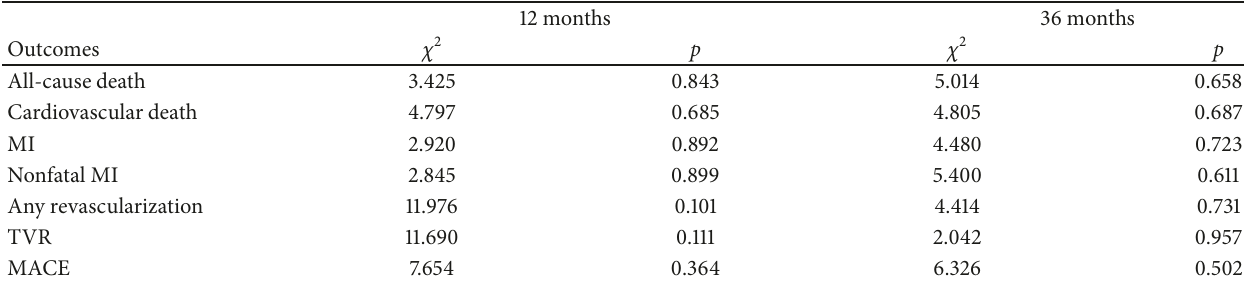
Table 5: Cox regression survival analysis comparing the event rate in the 2